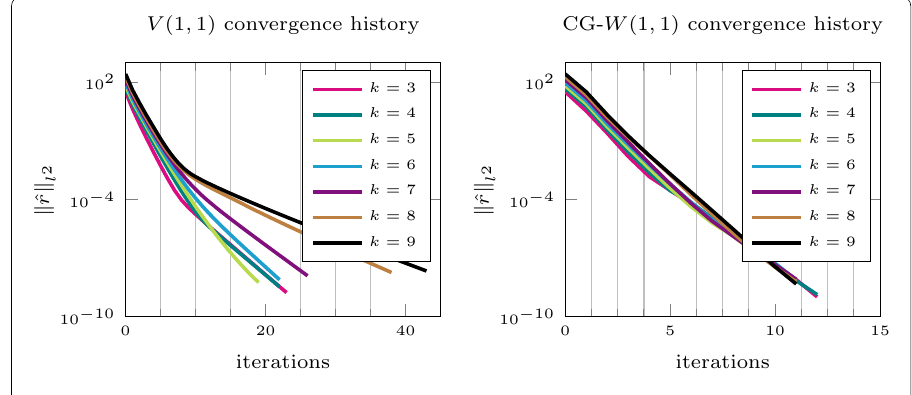
Fig. 7 Convergence histories for the V (1 , 1)-cyle as a stand-alone solver (left) and the W (1 , 1)-cycle as a preconditioner in CG (right) Table 2 Measured iteration numbers n CG for the preconditioned CG method attained for the model problem (19) on the configuration depicted in Fig. 1 using a fixed